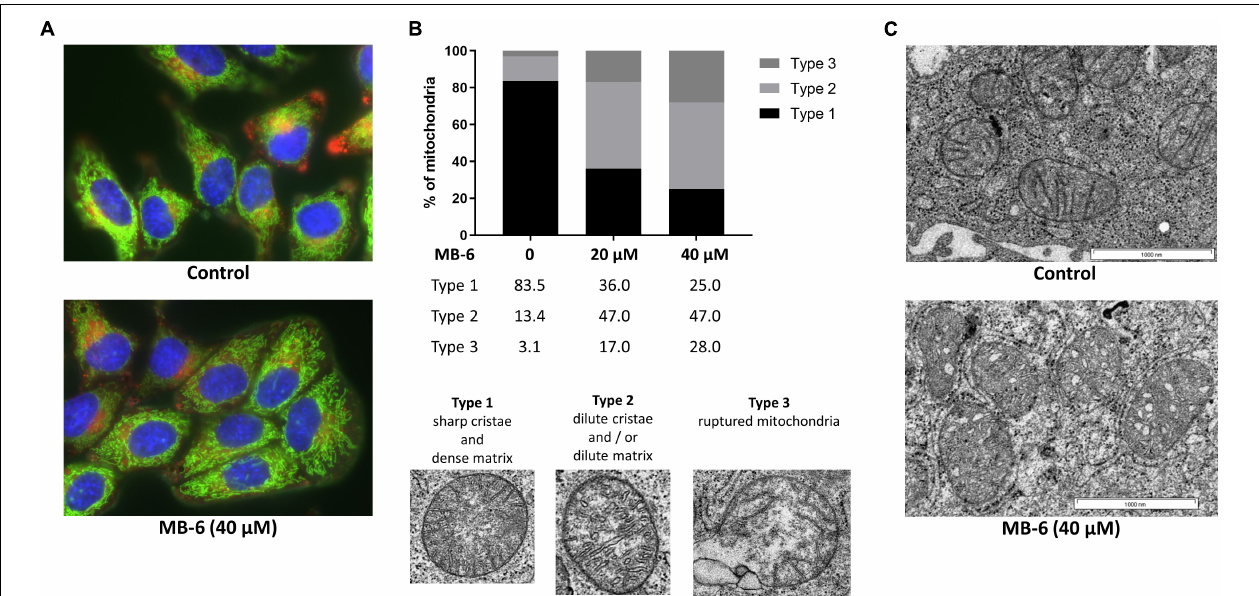
FIGURE 2 | MB-6 impairs the mitochondrial ultrastructure. (A) Fluorescence imaging of cells stained with Hoechst R (cid:13) 33342, MitoTrackerTM Green FM and LysoTrackerTM Deep Red shows intactness of the mitochondrial tubular network as well as no increased lyosomal activity. (B) Quantitative analysis of mitochondria demonstrates that MB-6 causes dose-dependent decline in type 1 mitochondria (sharp, elongated cristae) along with an increase in type 2 (rounded, ballooned cristae) and type 3 (ruptured membranes) mitochondria. Type 1 resembles mitochondria with an electron-dense matrix and crisp, tubular cristae; type 2 mitochondria show enlarged, bloated cristae and/or a decreased matrix density; type 3 mitochondria possess ruptured outer membranes and are thus considered non-functional. (C) Electron micrographs of MB-6 treated cells reveal alterations in mitochondrial ultrastructure. Treatment results in a concentration-dependent increase in mitochondria with diluted, ballooned cristae and/or disrupted cristae structure along with a decrease in mitochondria with sharply defined, dense cristae. Scale bars equal 1,000 nm.